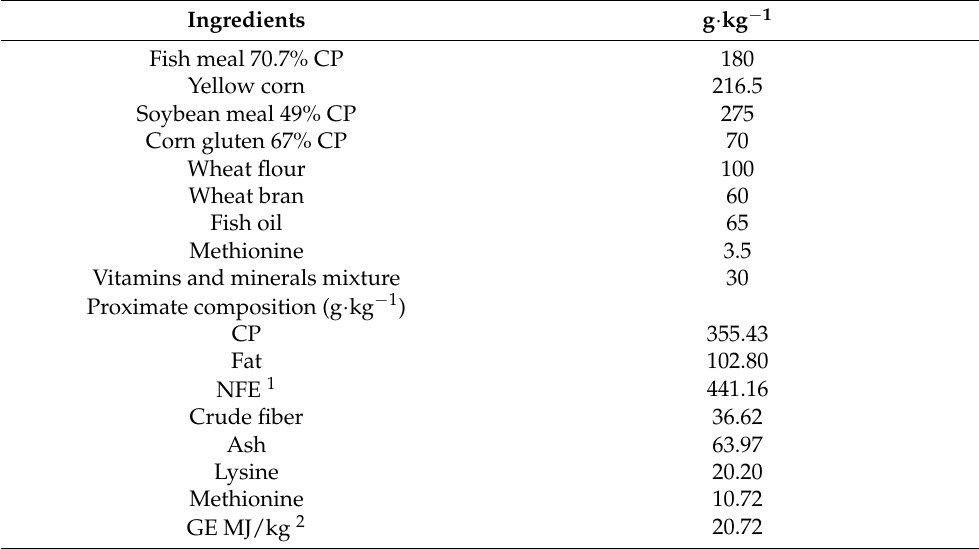
Table 1. Proximate chemical composition of the basal diet (g · kg − 1 on a dry weight basis). Ingredients Fish meal 70.7% CP 180 Yellow corn